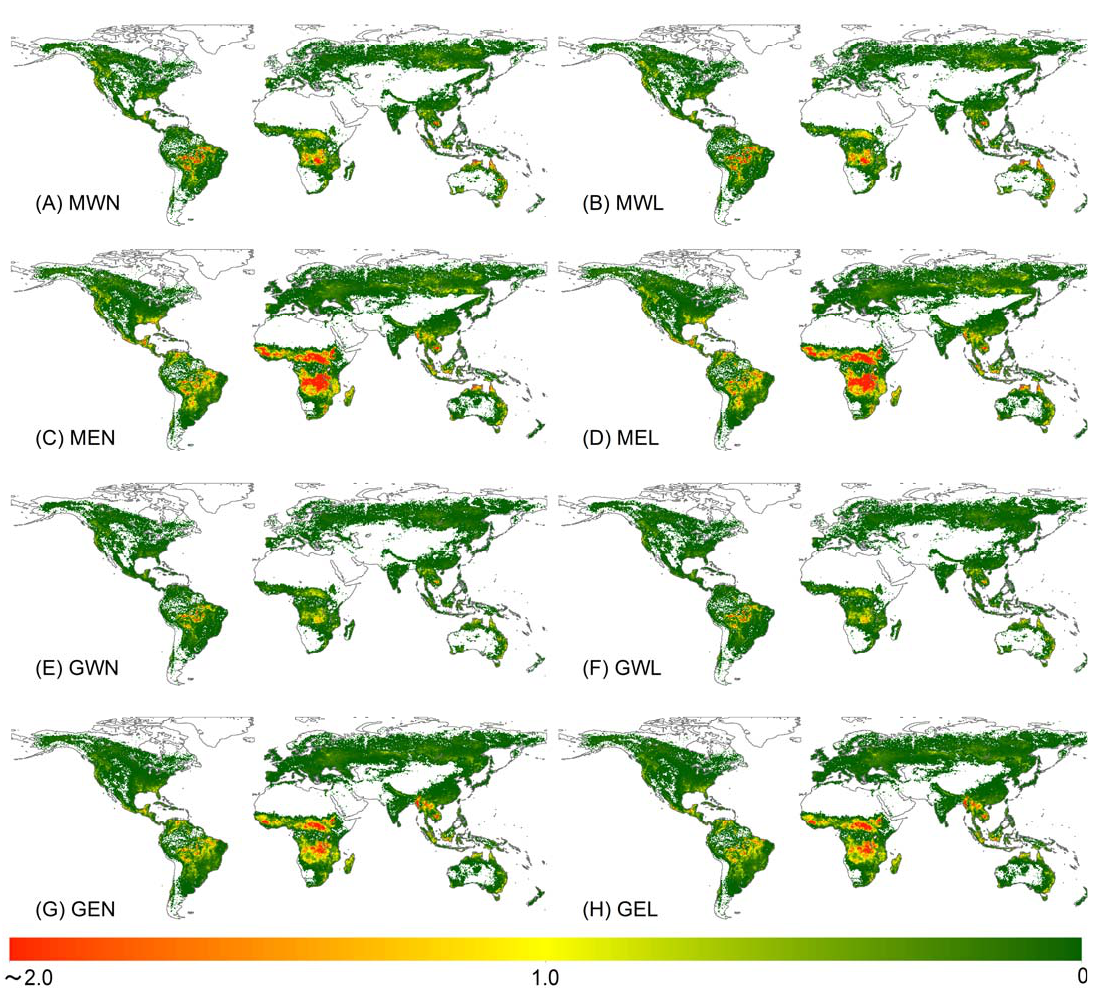
Figure 4. Global maps of average CO 2 emissions (Tg CO 2 grid − 1 year − 1 ) of the eight inventories from 2001 to 2020. Grid size is 50 km × 50 km. Table 3. Average annual CO 2 emissions for the previous studies. Numbers in parentheses are from 2003 to 2019.